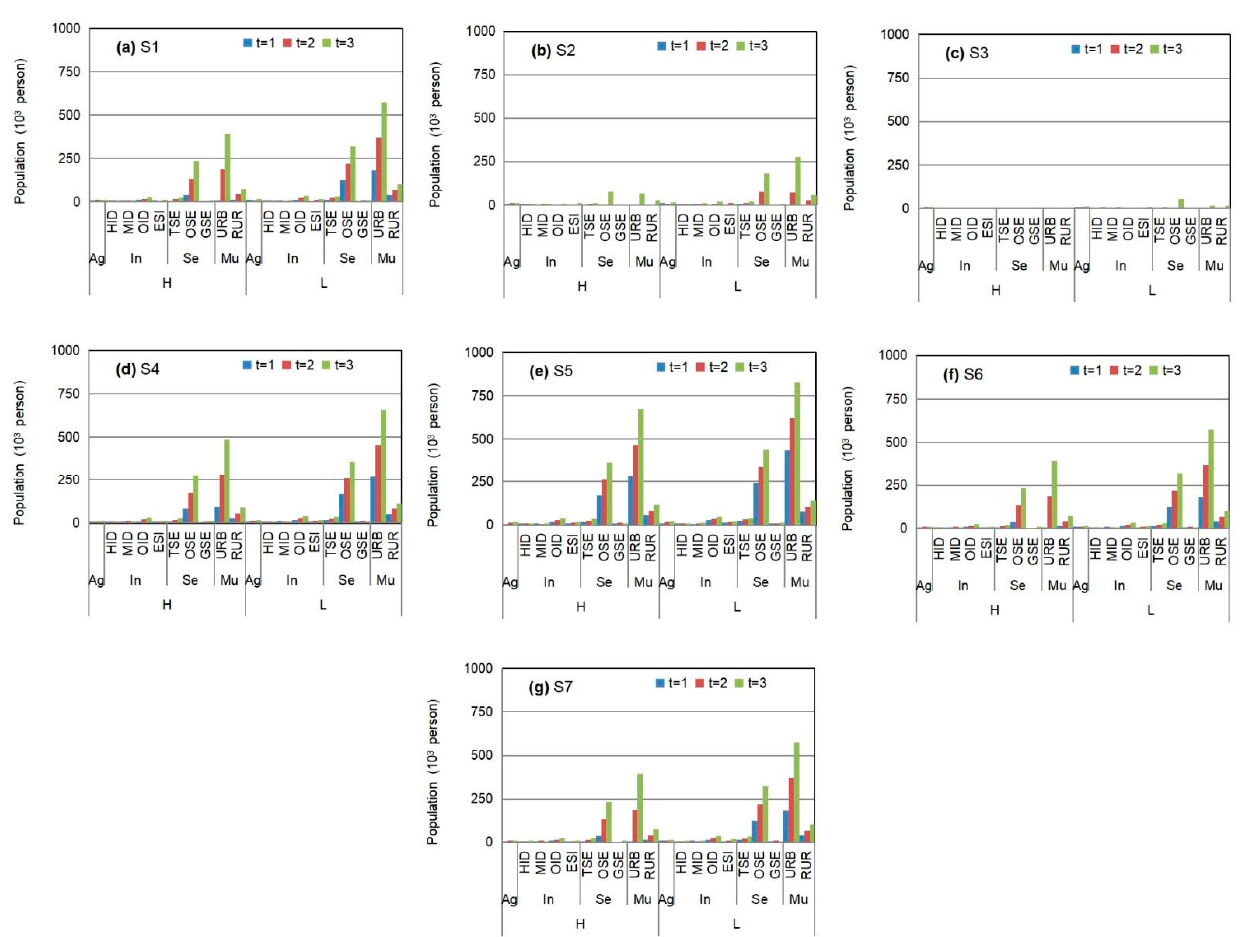
Figure 7. The lower population reduction based on combined policies (S1 to S7) compared to S0 ( α = 0.6 and β = 0.99) (agricultural sector denoted as “Ag”, industrial sector denoted as “In”, service sector denoted as “Se”, municipal sector denoted as “Mu”; heavy-consumption industry plant denoted as “HID”, medium-consumption industry plant denoted as “MID”, other industry plant denoted as “OID”, energy-supply industry plant denoted as “ESI”, traditional service industry plant denoted as “TSE”, other service industry plant denoted as “OSE”, environmental protection industry plant denoted as “GSE”, urban municipal consumption plant denoted as “URB”, rural consumption plant denoted as “RUR”; high level of resource availability denoted as “H”, low level of resource availability denoted as “L”) (( a – g ) are the population reduction under S1 to S7)